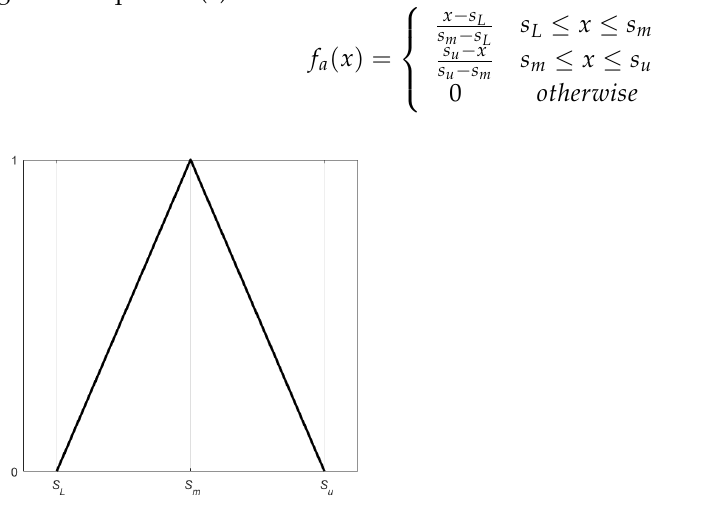
Figure 5. Triangular fuzzy number.